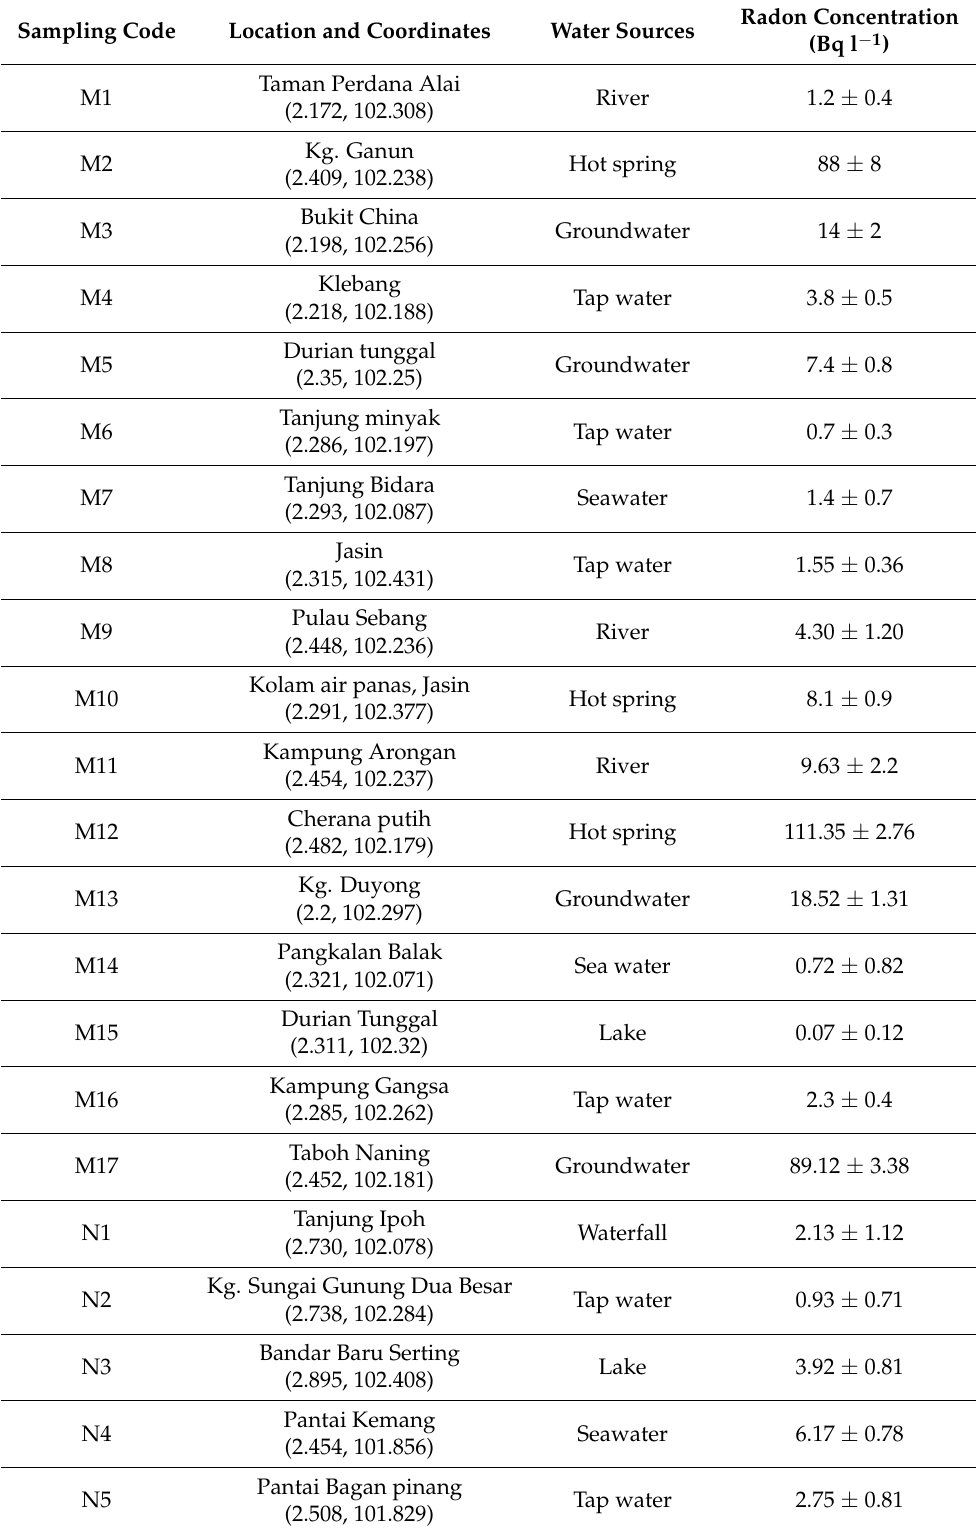
Table 1. Radon concentrations in water samples from the studied